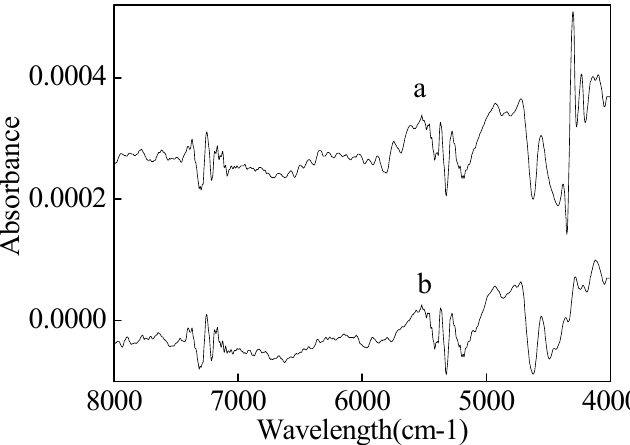
Figure 2. First derivative near infrared spectra of the alkali-free cloth: (a ) original (b) preheated